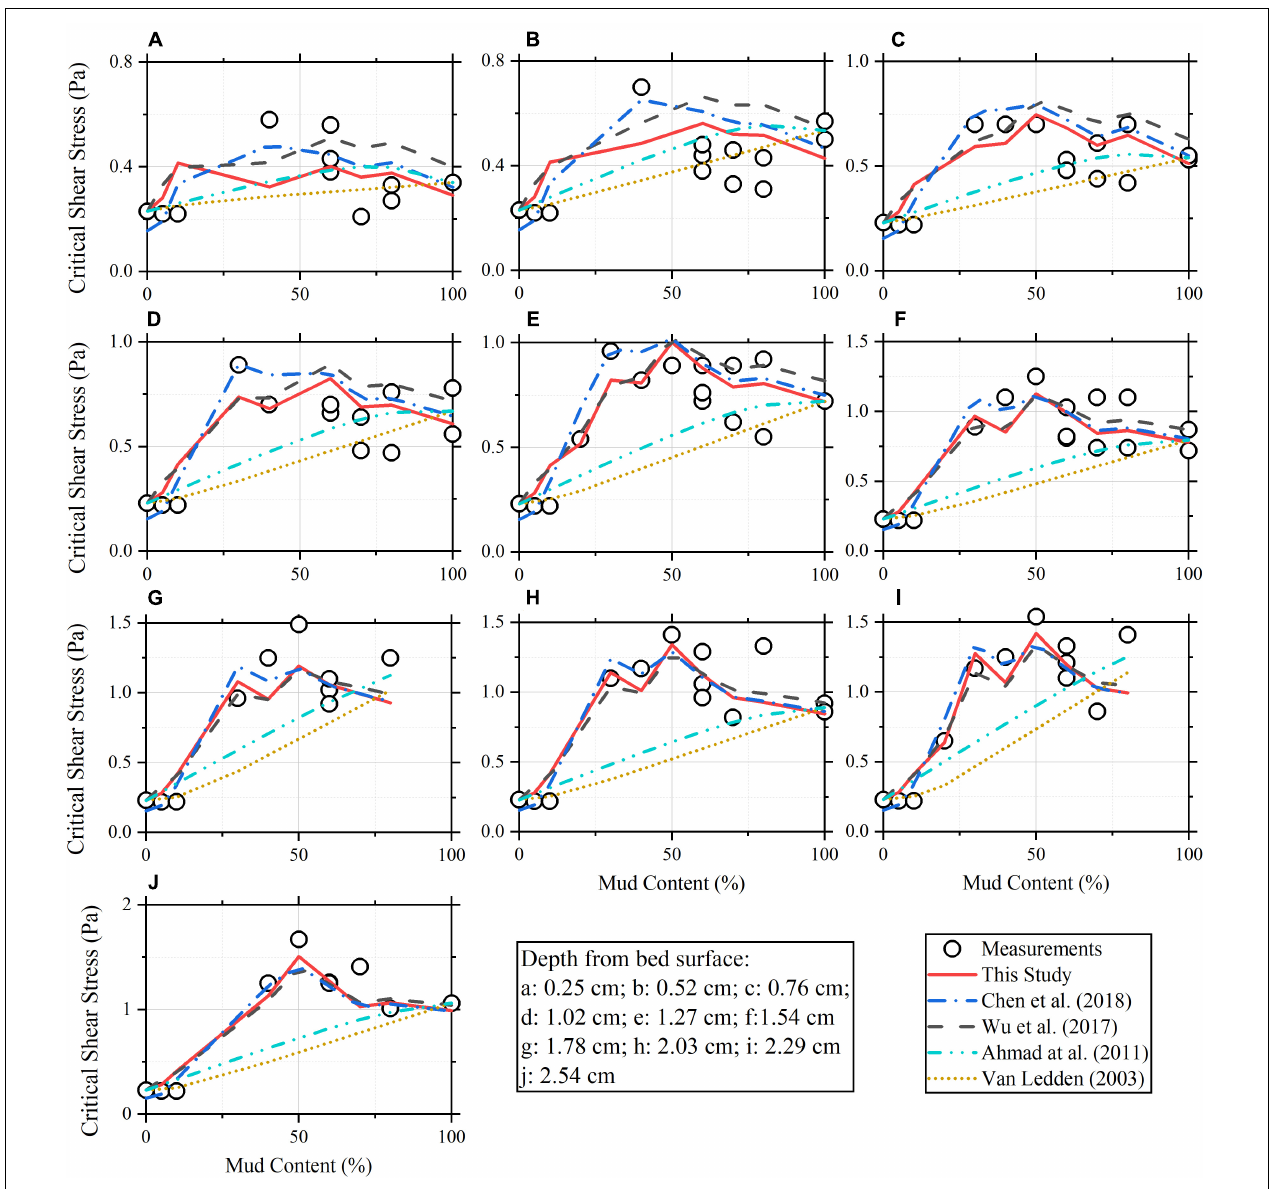
FIGURE 5 | The calculated and measured critical shear stresses vary with mud content for sediment at different soil depths in the case of Sharif (2003): (A) 0.25 cm; (B) 0.52 cm; (C) 0.76 cm; (D) 1.02 cm; (E) 1.27 cm; (F) 1.54 cm; (G) 1.78 cm; (H) 2.03 cm; (I) 2.29 cm; and (J) 2.54